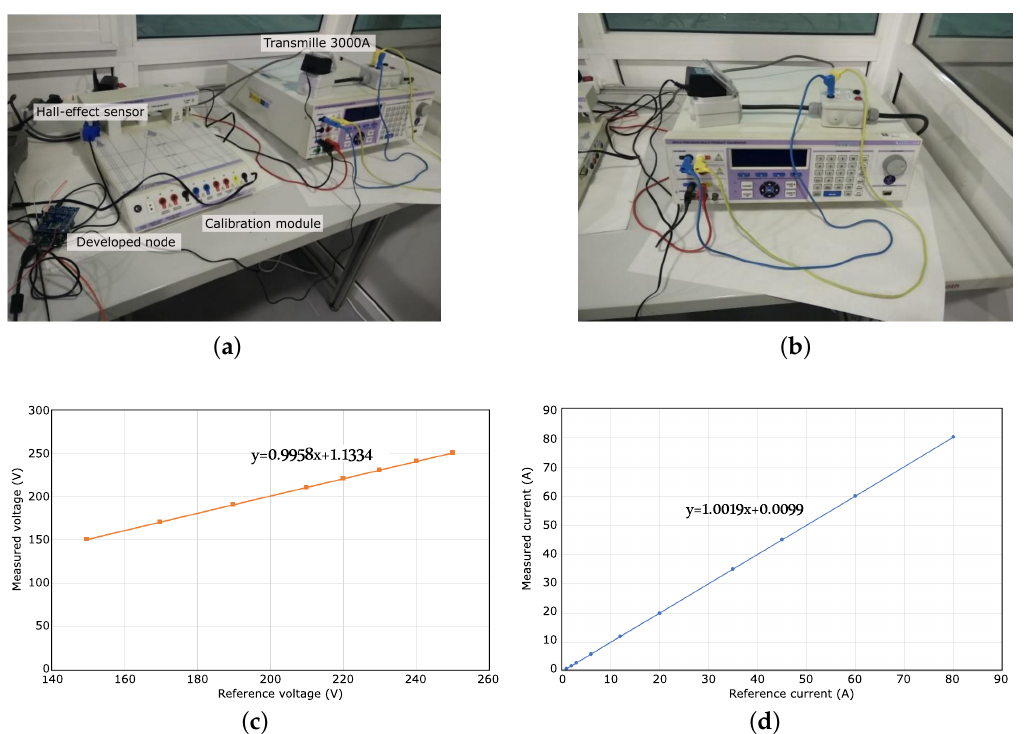
Figure 5. Voltage and current-sensor calibration: ( a ) calibration laboratory details; ( b ) multi-product calibrator equipment; ( c ) voltage calibration results; and ( d ) current calibration